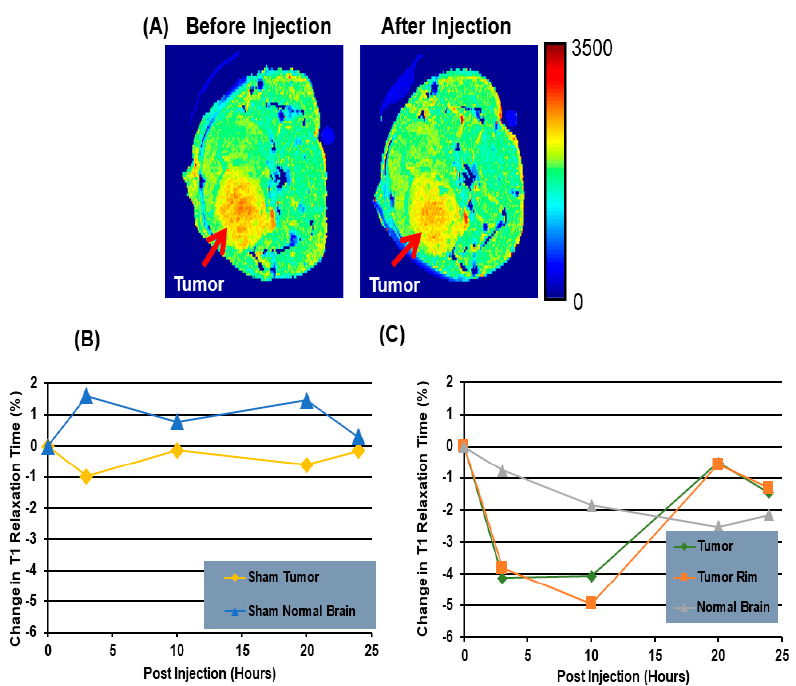
Figure 3. Use of saposin C-dioleoylphosphatidylserine (SapC-DOPS) as a carrier for magnetic resonance imaging (MRI) contrast agents in a mouse brain cancer model. ( A ) High resolution MRI of a glioma in a mouse. Tumor T1 relaxation time (s − 1 ) maps before and 10 h after injection of gadolinium-DTPA-bis(stearylamide) (Gd-DTPA-BSA)/SapC-DOPS vesicles. ( B ) Percent change in T1 after only SapC-DOPS vesicle injection in the sham tumor and sham normal brain. ( C ) Percent change in T1 after injection of Gd-DTPA-BSA/SapC-DOPS vesicle in the tumor, tumor rim cells and normal brain.